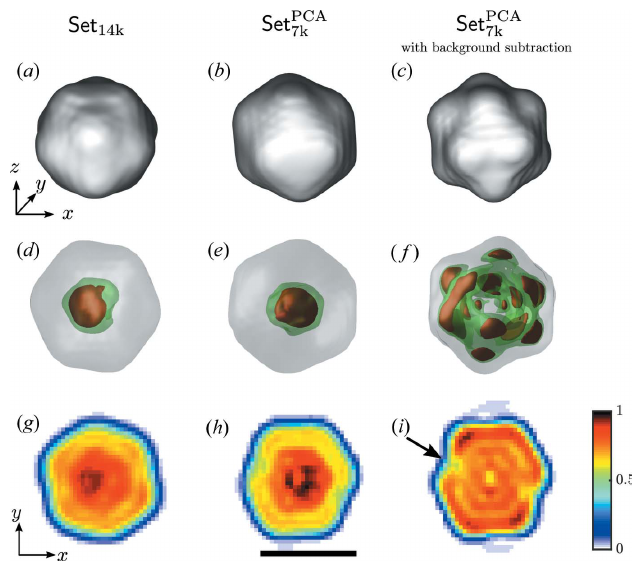
Figure 10 PR772 virus electron-density reconstruction obtained from different data selections. ( a )–( c ) Isosurface at 10% of the maximum electron density. ( d )–( f ) Isosurface at 10%, 82% and 89% of the maximum electron density. ( g )–( i ) Slices through the particle center in the x – y plane. Low- density site in ( i ) is marked by a black arrow. Black scale bar denotes 50